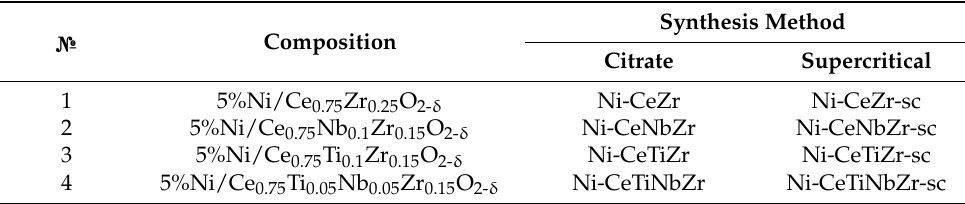
Table 1. Catalysts’ compositions and abbreviations.